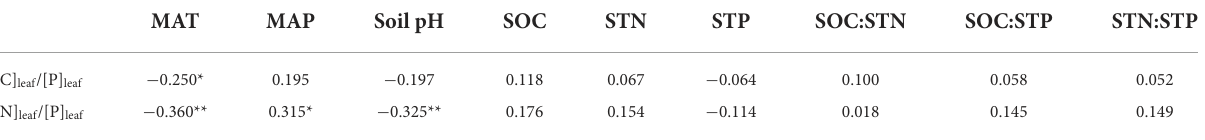
TABLE 4 Pearson’s correlations between environmental factors and leaf carbon-to-phosphorus ratio and the nitrogen-to-phosphorus ratio of Potentilla anserina . MAT MAP Soil pH SOC STN STP SOC:STN SOC:STP